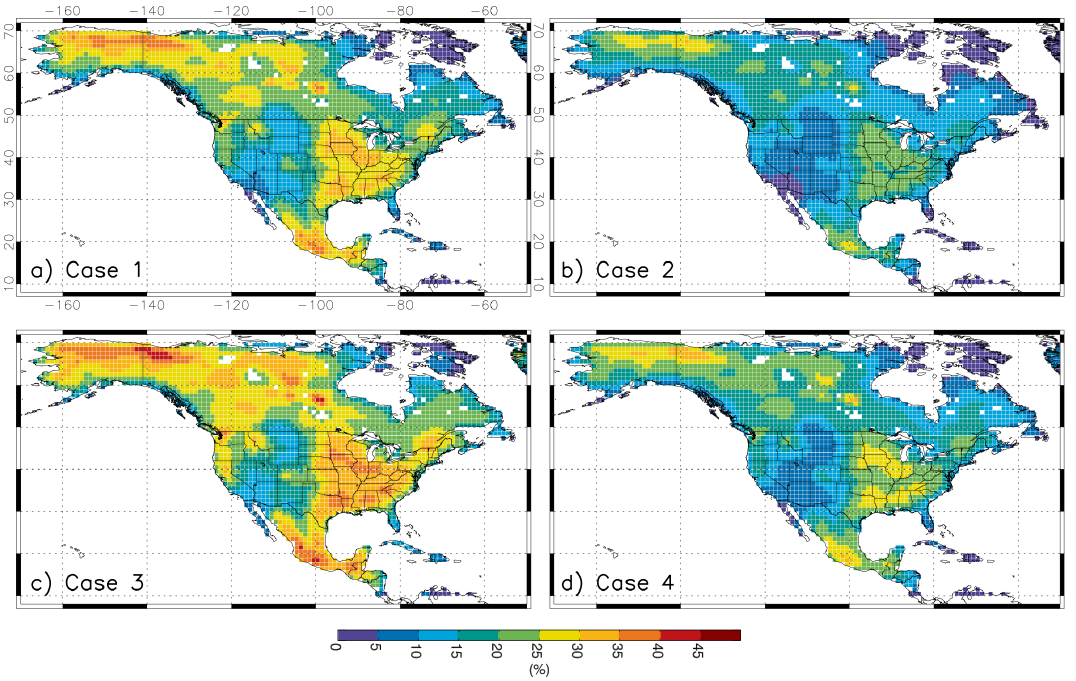
Figure 8. Weekly fractional flux uncertainty reduction (RMS over the 4 months) for (a) case 1 (1.57µm and 0.5ppm RRV error), (b) case 2